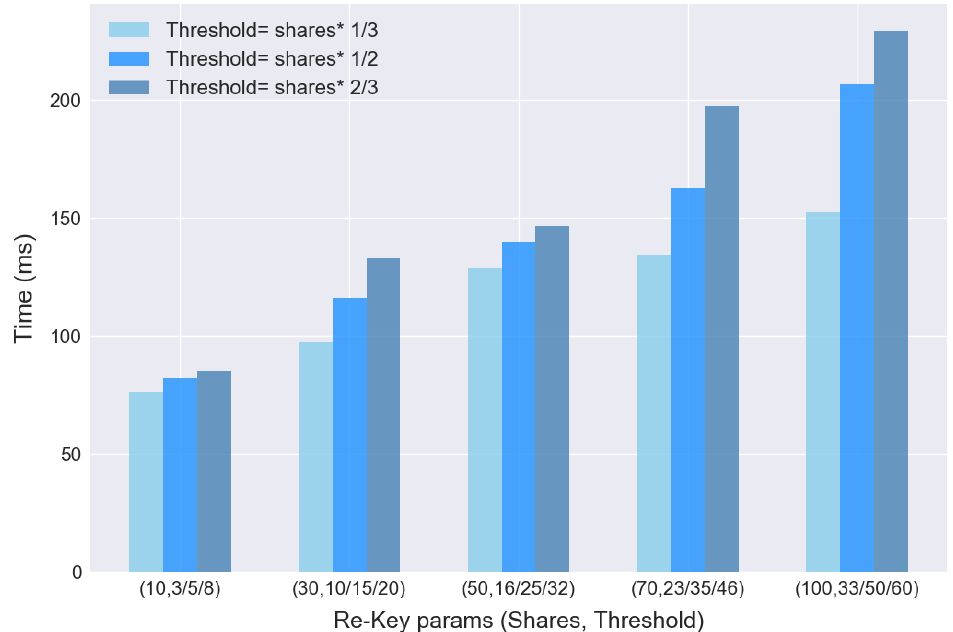
Figure 7. The impact of re-encryption key parameters on data re-encryption processing